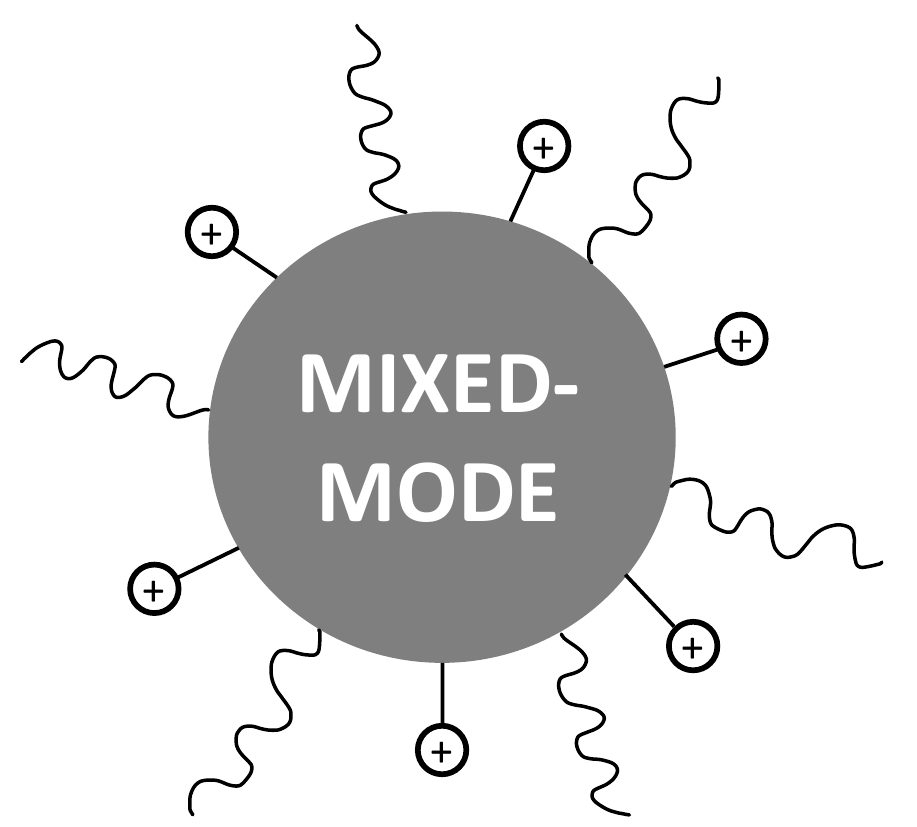
Figure 5. Scheme of a typical stationary phase used for Mixed-Mode Chromatography. The particle is functionalized with alkylic chains (e.g., C8) and charged groups (e.g., quaternary